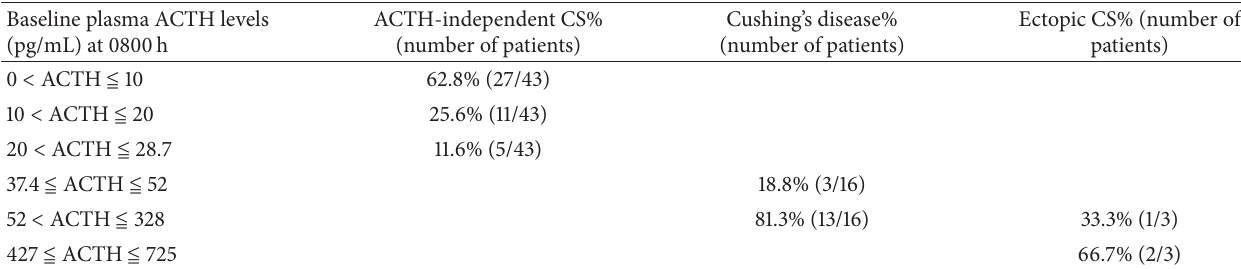
Table 3: Comparison of baseline plasma ACTH levels between patients with ACTH-independent Cushing’s syndrome and ACTH-dependent Cushing’s syndrome